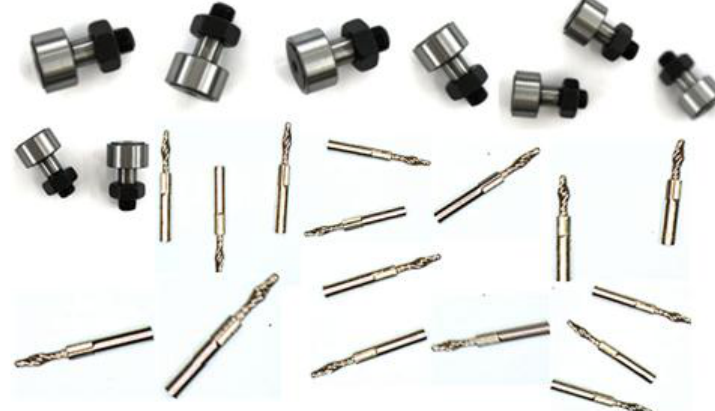
Figure 7. Example of autonomous collection of experimental datasets, including the 0.8 cm darning needle dataset and the KR22 bearing dataset.